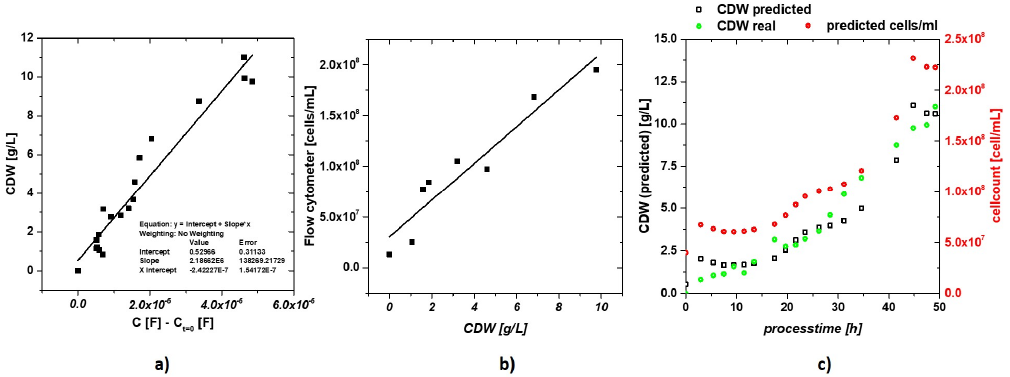
Figure 4. ( a ) Capacitance signal subtracted by the signal at t = 0 to compensate for long time drifts of the system fitted to the measured dry cell weight; ( b ) correlation of CDE to cell number measured by flow cytometry; ( c ) predicted CDW and cell concentration signals based on the impedance